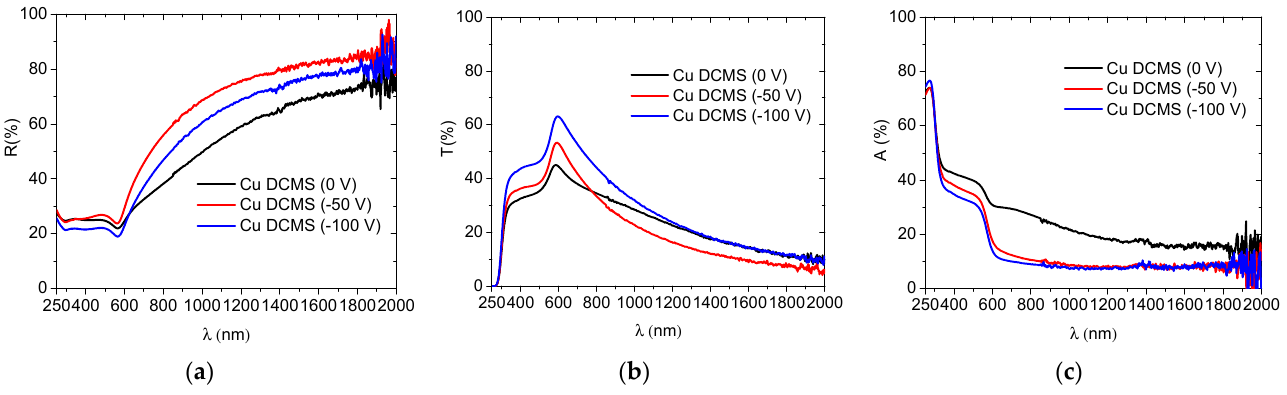
Figure 2. Comparison between reflectivity ( a ), transmission ( b ), and absorption ( c ) spectra of copper thin films obtained by using DCMS techniques at different substrate bias voltages.